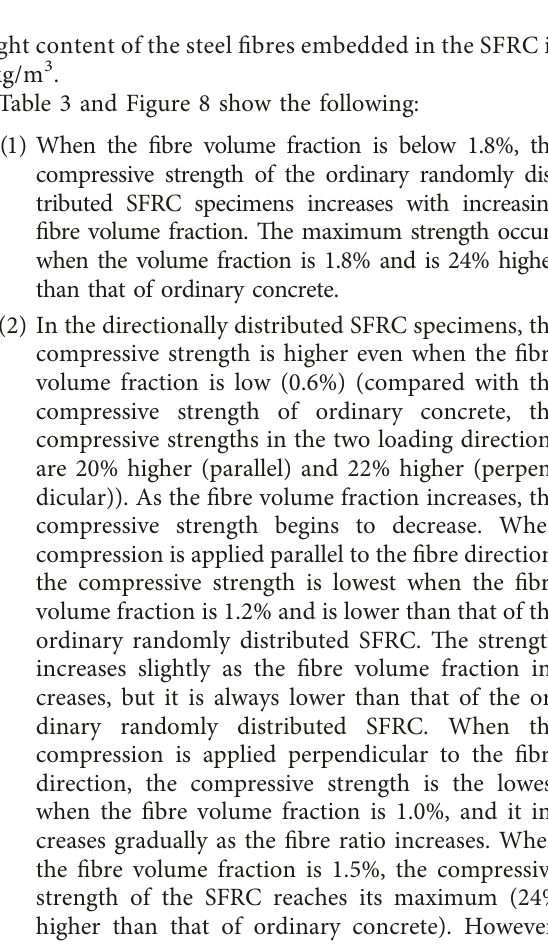
Table 3 and Figure 8 show the following: